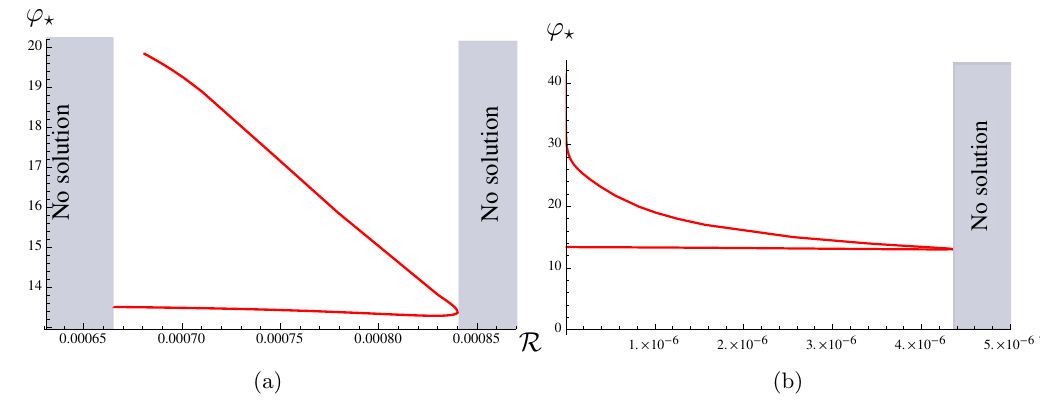
Figure 16 . Equilibrium brane position ’ ? vs. R for R > 0. Results are obtained for bulk potential (4.1), brane quantities (4.2) and parameter values (4.9). The left (cid:12)gure (a) is for b